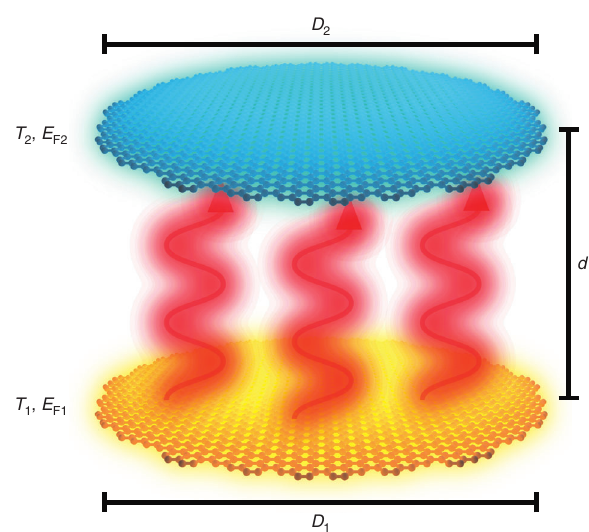
Fig. 1 Sketch of the structure considered for ultrafast radiative heat transfer. We study heat transfer between two parallel coaxial graphene disks placed in vacuum and separated by a small distance d . Each disk ‘ ¼ 1 ; 2 is characterized by its diameter D ‘ , Fermi energy E temperature T ‘ , with T 1 > T